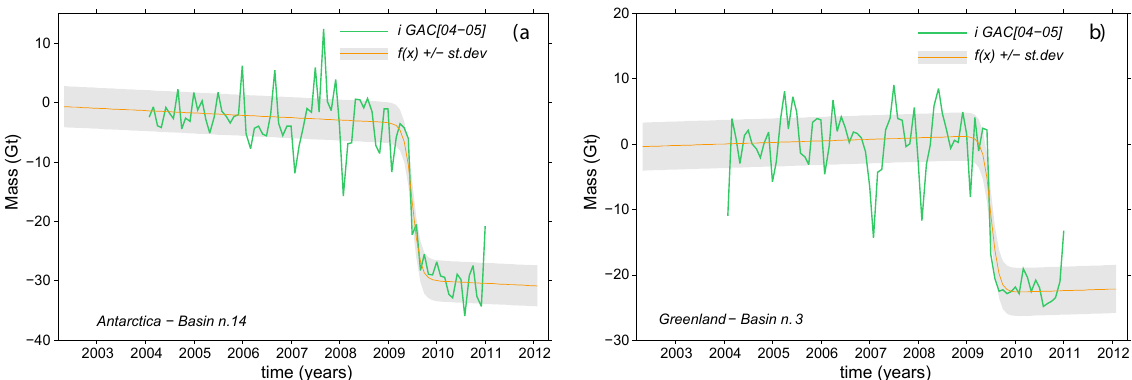
Fig. 1. Difference between the GAC-RL04 and the GAC-RL05 (green line), and the fitted function (orange line) with its standard deviation (grey band). The fitted function is a continuous function of time, so the jump might look smoother than the real one. Solution for basin 14 for Antarctica (a) and basin 3 for Greenland (b)